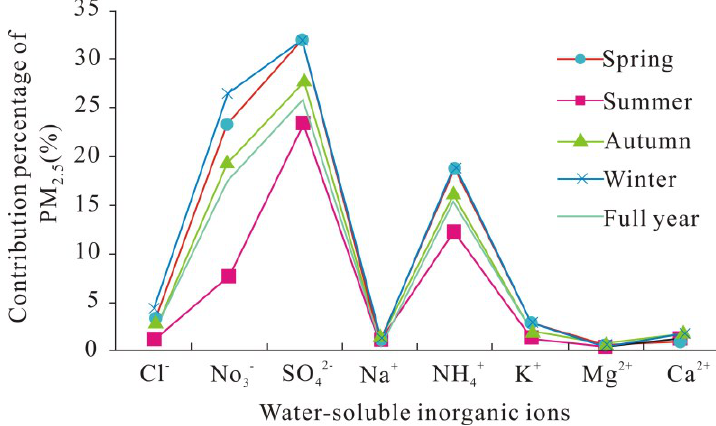
Figure 4. Seasonal variation of eight inorganic ions accounts for the total mass concentration of PM 2.5 in Wuhan during observation period.